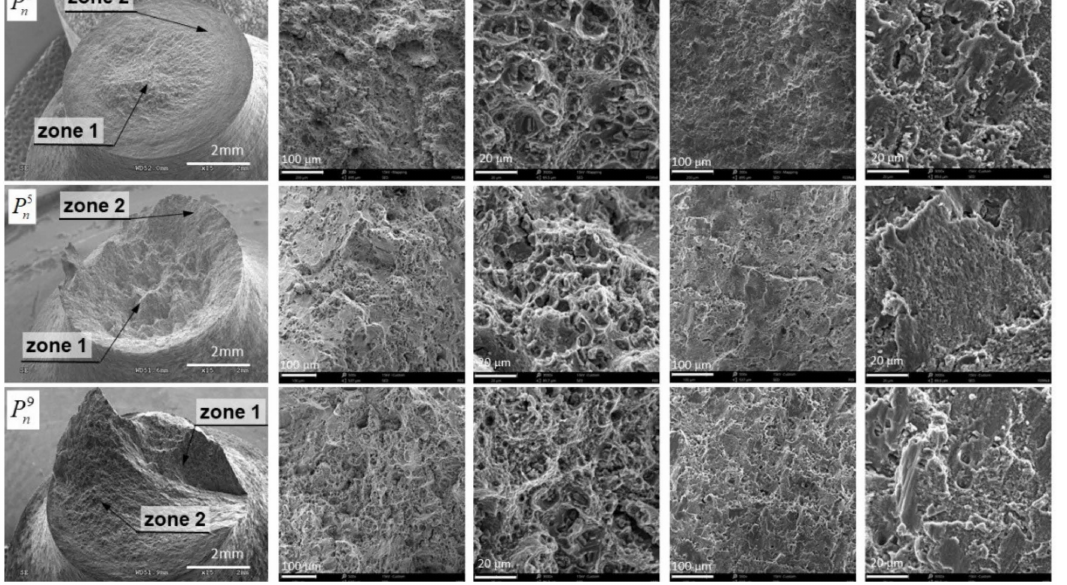
Figure 16. Fracture surfaces for the specimen with a notch radius r K = 8